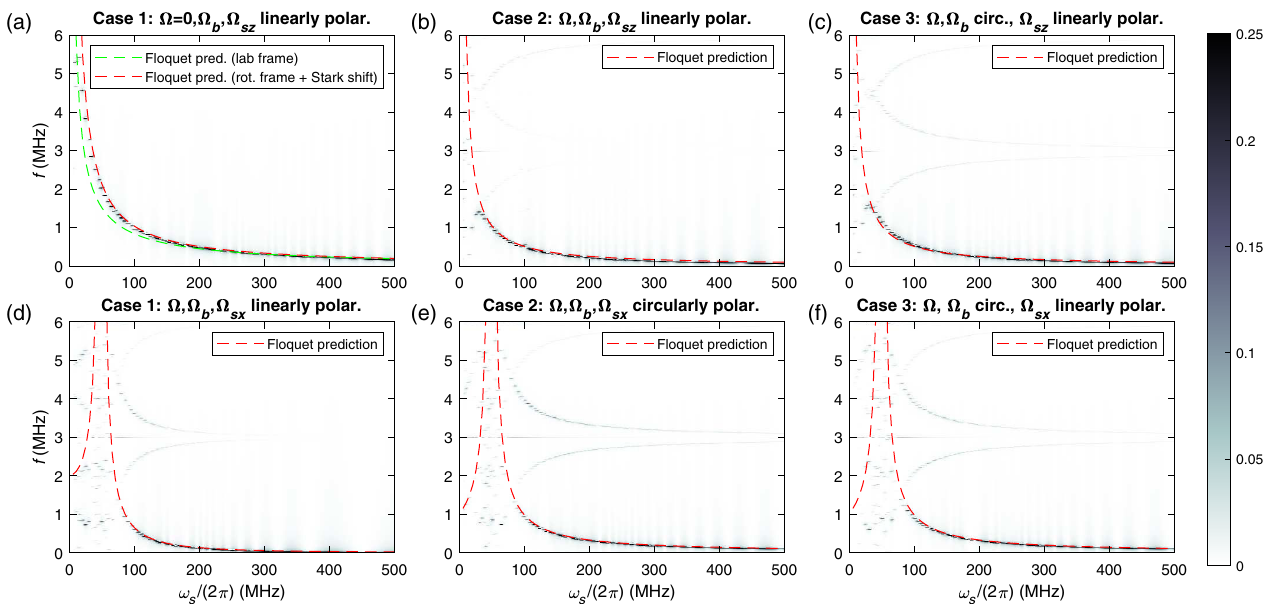
FIG. 7. Signal frequency ω s sweep simulation. The parameters are the same as in Fig. 6 except for the phase ϕ b ¼ π = 2 , initialization, and readout state jþi for panels (b) – (f), j 0 i for panel (a), and the signal frequency ω s being swept. Resonance conditions ω b ¼ ω s þ ω 0 (a), ω b ¼ ω s þ ω 0 − Ω (b,c), and ω b ¼ ω s þ Ω (d) – (f) are satisfied when sweeping ω s .